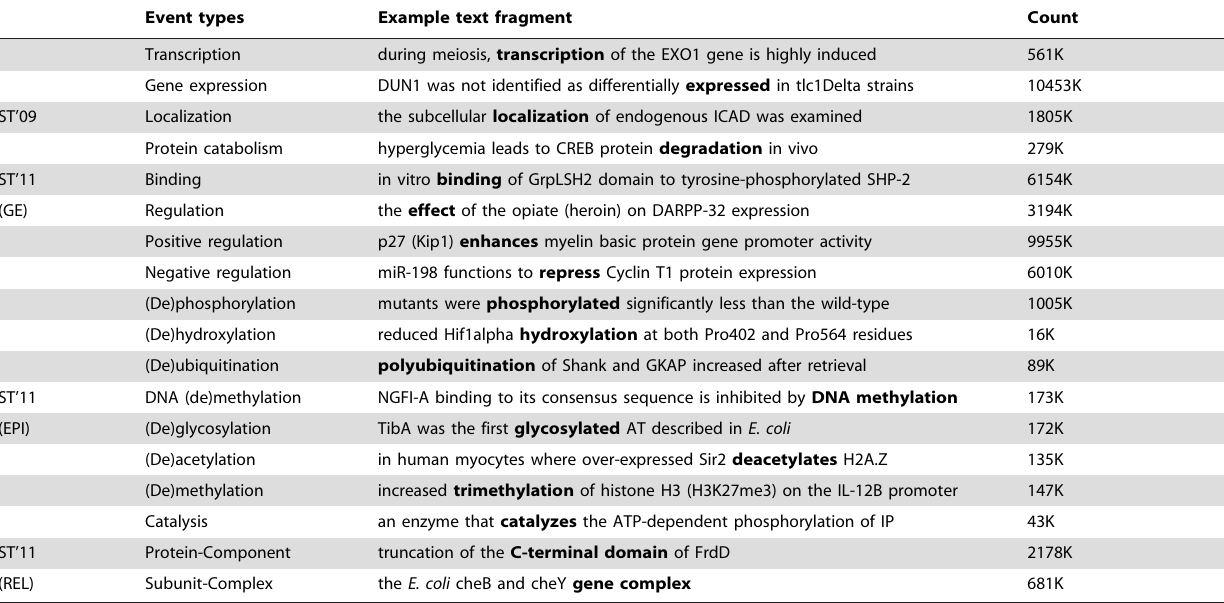
Table 1. Event types processed in this